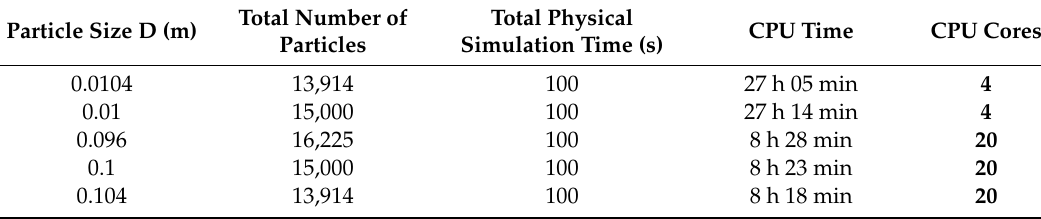
Table 1. Simulation details for each configuration